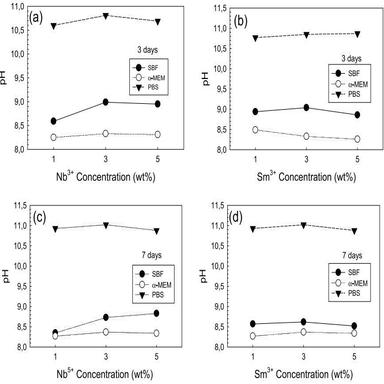
Graphs showing the change in the pH of the SBF,α-MEM, and PBS after contact with the Nb5+ (left column), Sm3+ (right column)-containing bioactive glass particles for (a),(b) 3 days; (c),(d) 7 days.